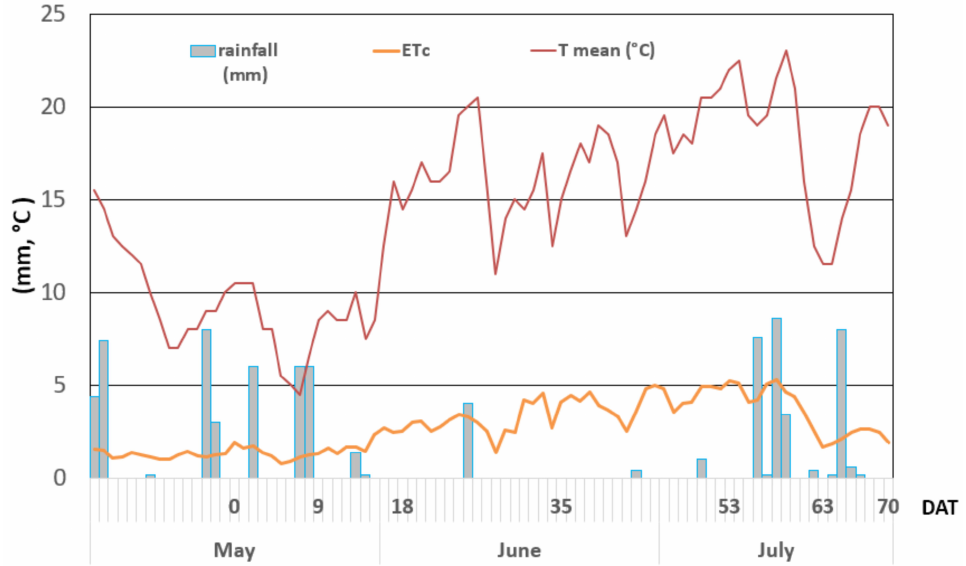
Figure 1. Meteorological data and ETc at the experimental site: mean daily temperatures ( ◦ C), daily rainfall and ETc